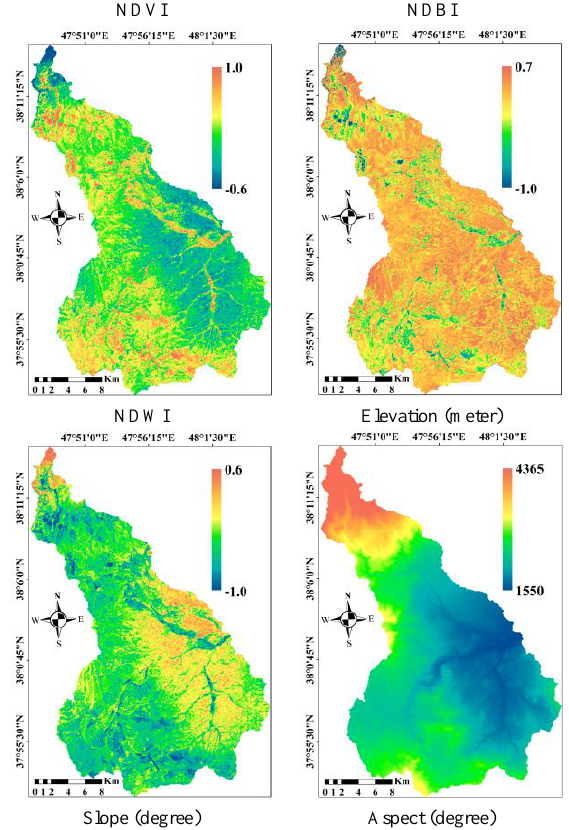
Surface biophysical characteristics, topographical parameters and land use maps of the study area on 01/07/2018 are shown in Figure